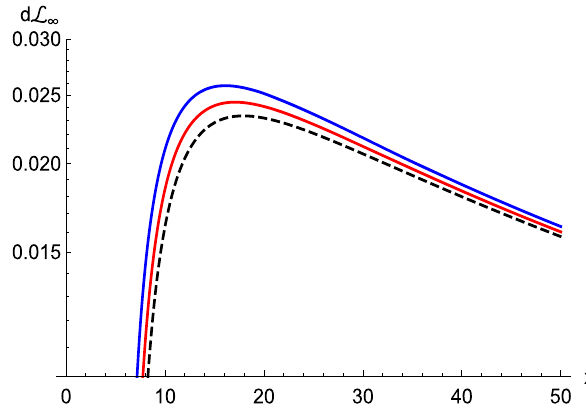
Fig. 7 Plots of the differential luminosity at infinity per unit accretion rate from a thin disk around a RGI-Schwarzschild black hole for ˜ ξ = ˜ ξ = 16 / 27 (blue) and ˜ ξ = 0 . 3 (red). The dashed line shows the same c for a disk around the classical solution ( ˜ ξ = 0)